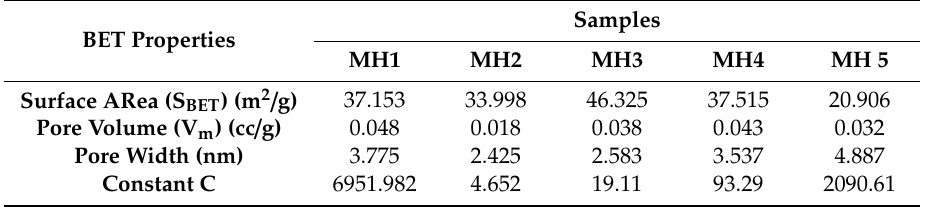
Table 4. Brunauer–Emmett–Teller (BET) properties of synthesized nanomaterials